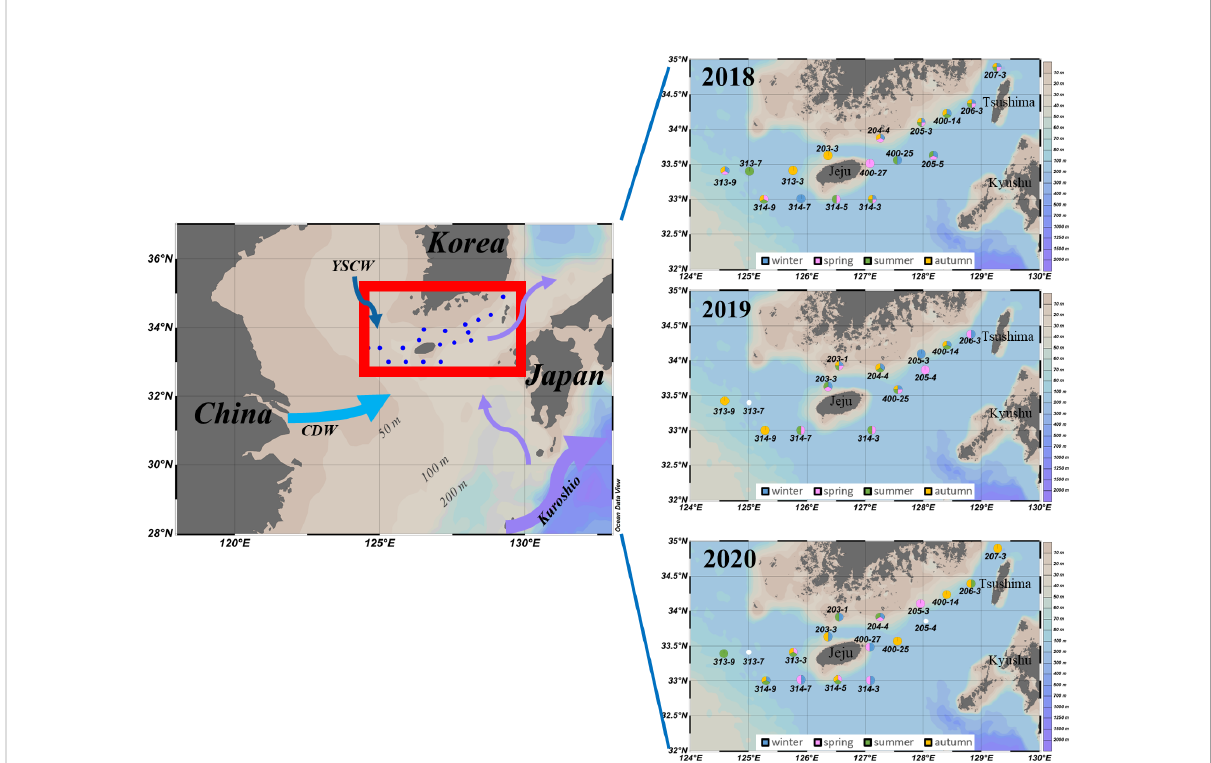
sampler fi tted with Niskin bottles. The light depths were determined at each station based on Lambert – Beer ’ s law. Light depths (30% and 1%) were calculated by a Secchi disk using a vertical attenuation coef fi cient ( K d = 1.7/Secchi depth) described in Poole and Atkins (1929). The vertical hydrographic measurements (temperature and salinity) were collected using SBE9/11 CTD (Sea-Bird Electronics, Bellevue, WA, USA) sensors.